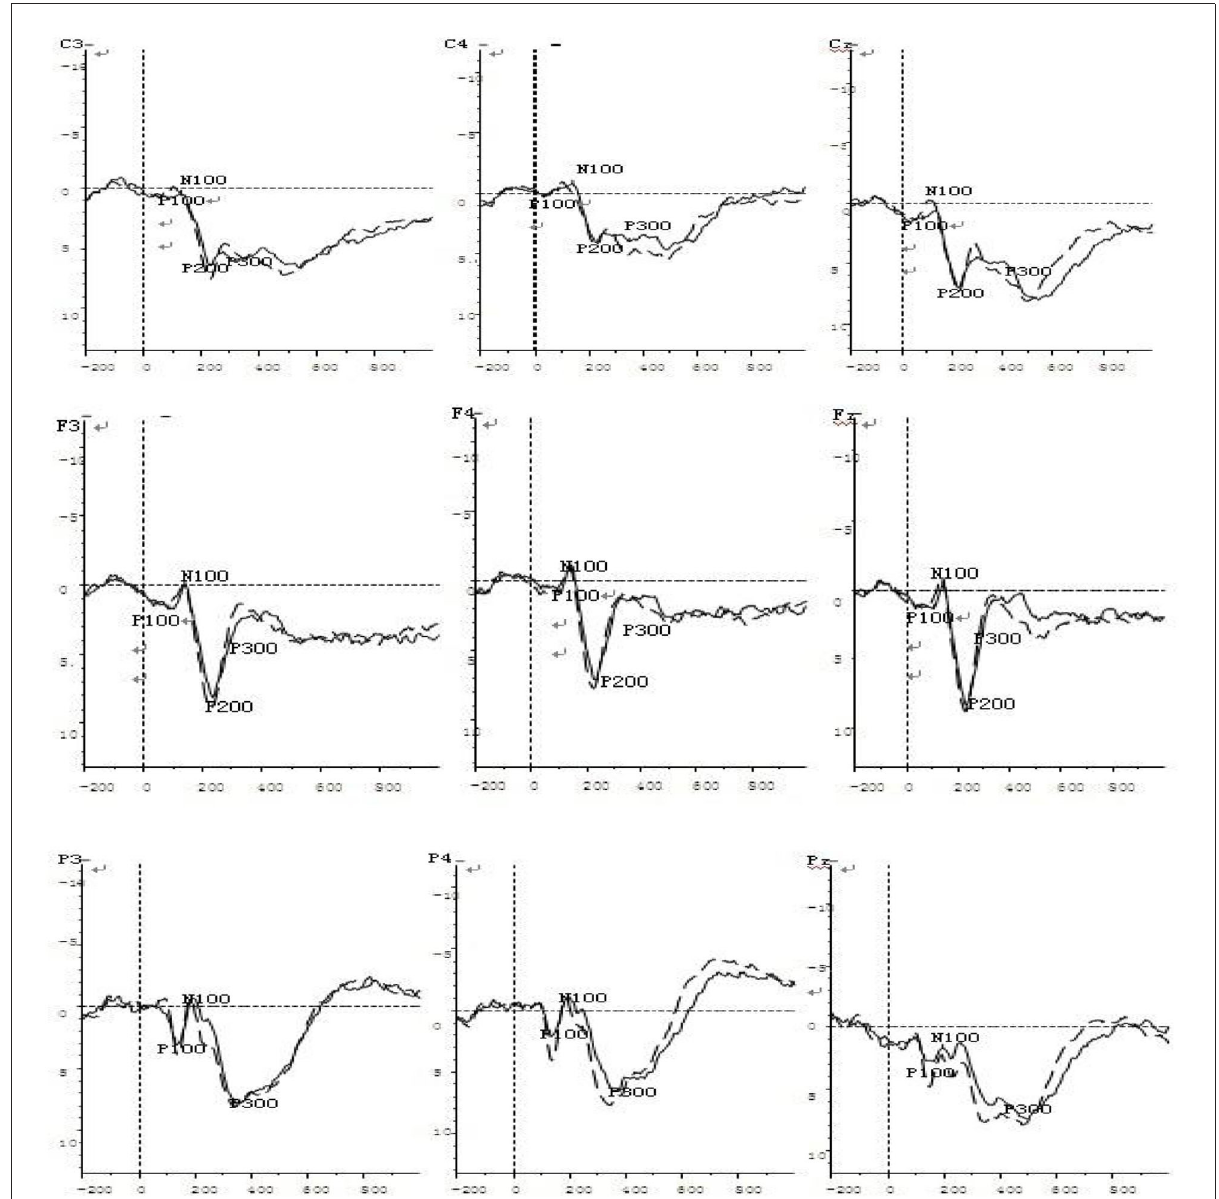
FIGURE2 ERP waveform diagrams under the negative priming condition in the DD (solid line) and TD groups (dashed line).